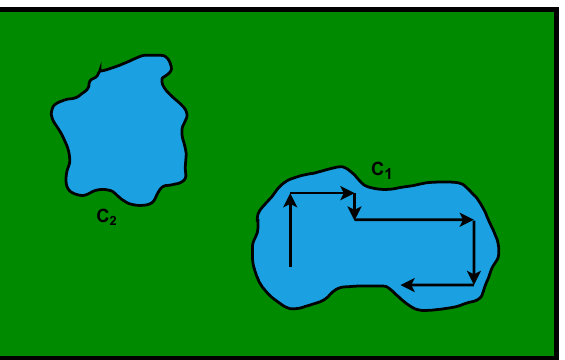
Figure 10. Scheme of the camera image with the problem of segmentation using neighborhood analysis algorithms.